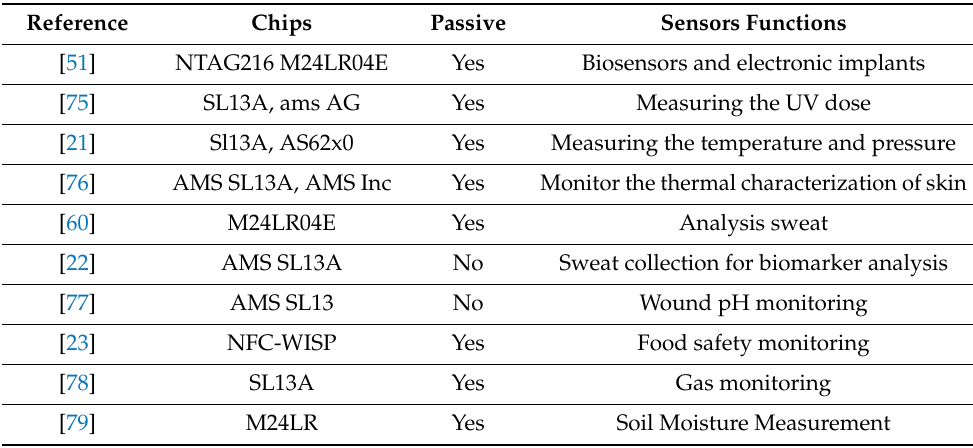
Table 4. References of NFC